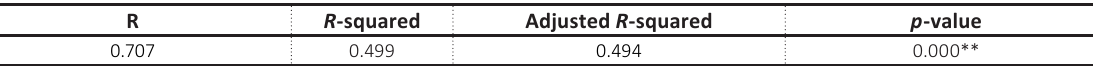
Table 14. Summary of adjusted R